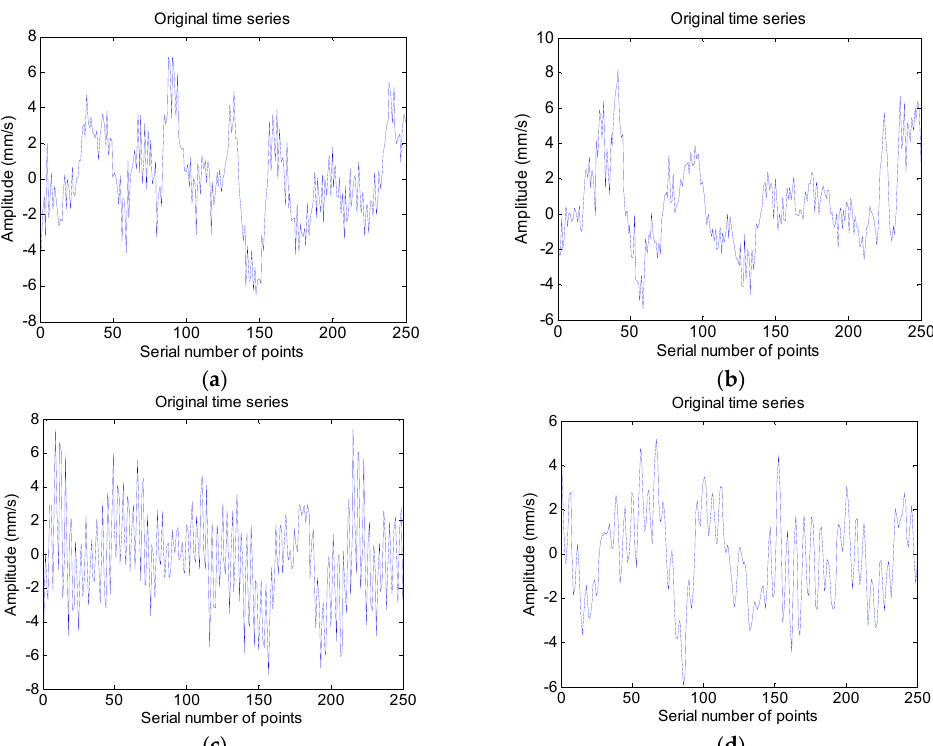
Figure 10. Time domain waveform; ( a ) Condition 1; ( b ) Condition 2; ( c ) Condition 3; and, ( d ) Condition 4.